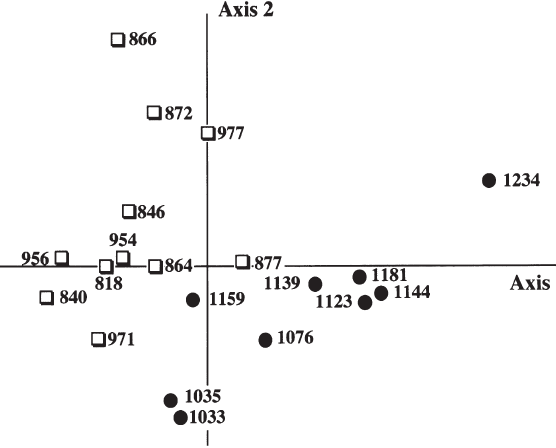
F IG . 4. – Canonical Correspondence Analyses along the two main axes based on the ‘true meiofauna’ densities for the 20 stations from the Straits of Magellan ( o ) and the Beagle Channel ( l ).